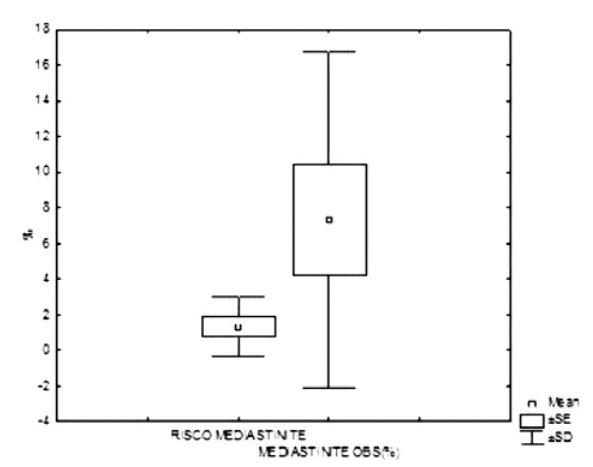
Fig. 1 - Comportamento médio da incidência de mediastinite observada e estimada segundo escore da NNECDSG.